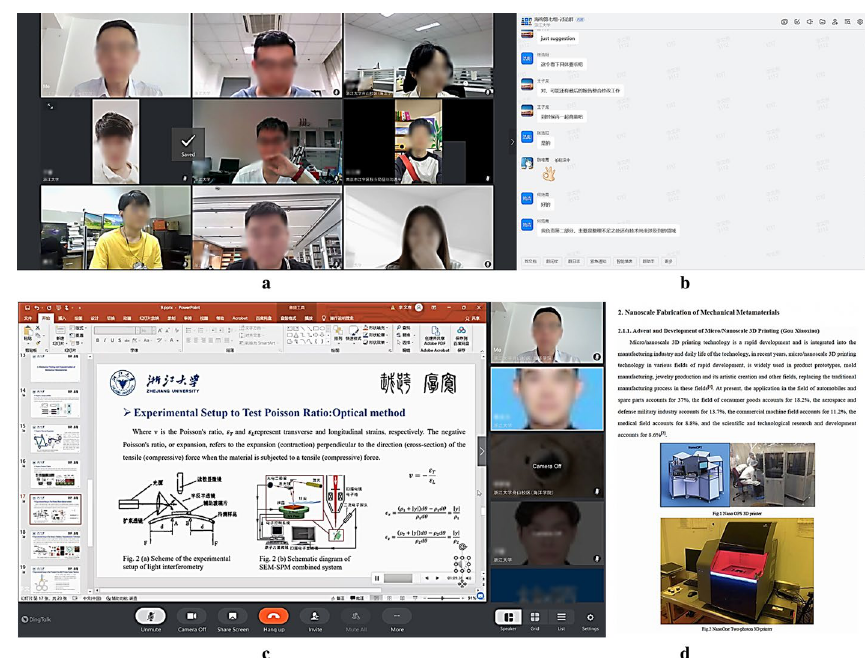
Fig. 1 Screenshots of instruction and learning procedures